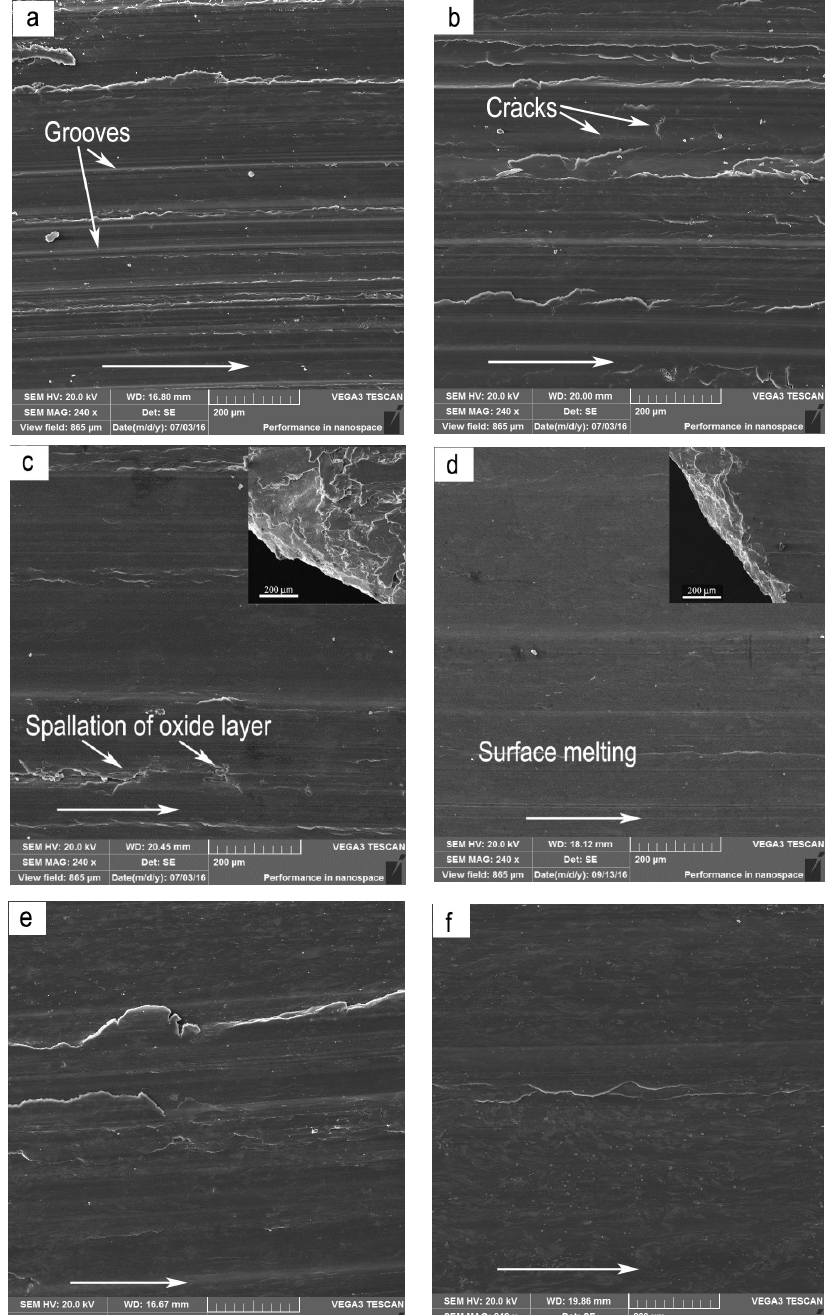
Figure 2. Worn surface morphologies at different applied loads and test temperature under 0.8 m/s: ( a ) 20 N, ( b ) 60 N, ( c ) 180 N, ( d ) 260 N, 50 ◦ C, ( e ) 20 N, ( f ) 80 N, 200 ◦ C. The edge of pins is also shown at the top right corner of the figures. The arrows show the sliding direction. Table 1. Chemical composition of worn surfaces at 0.8 m/s (wt.%).